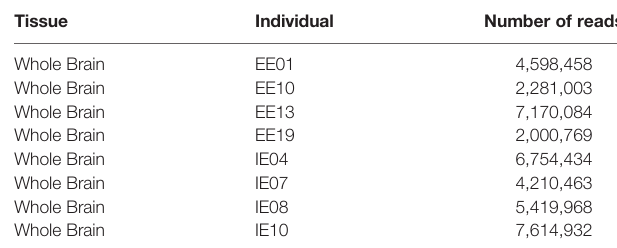
TABLE 1 | Total number of trimmed reads per brain sample of juvenile Colossoma macropomum .